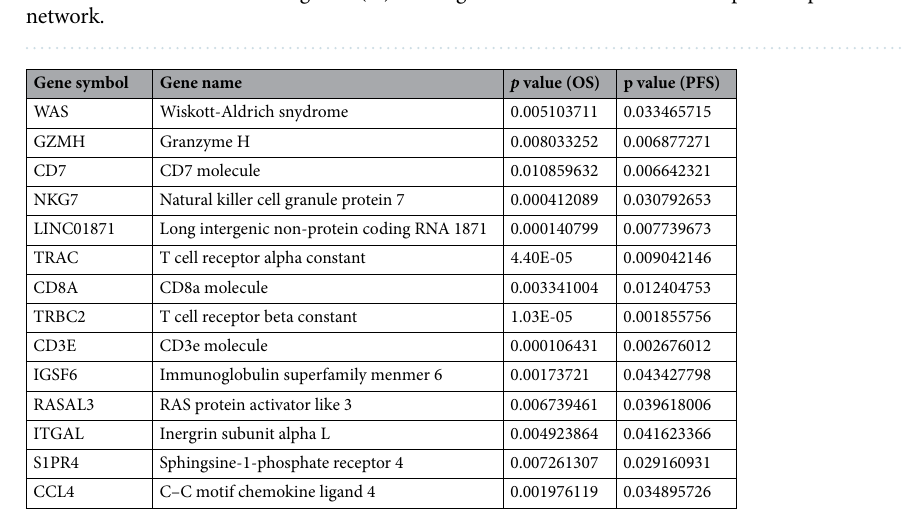
Table 1. 14 immune-related genes positively correlated with both OS and PFS of